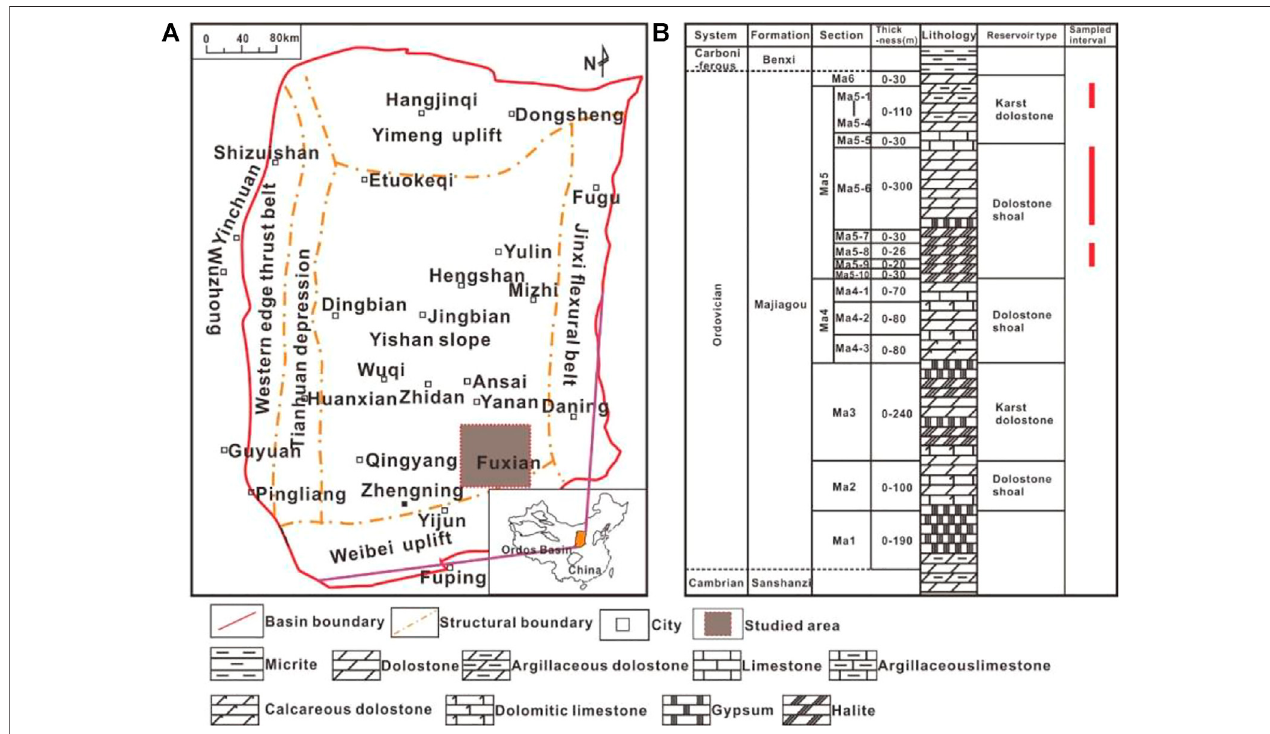
FIGURE 1 | (A) Structural units and studied location within the Ordos Basin (modi fi ed after Dai, 2016). (B) Lithologic column showing stratigraphy of the Majiagou Formation and sampled interval.